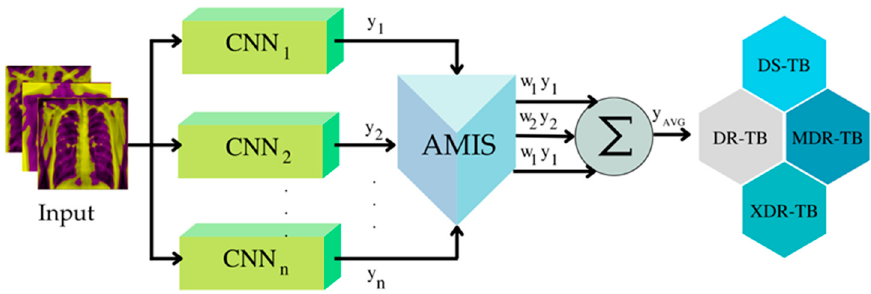
Figure 11. Framework of how to use weight generation to find the optimal weight of ensemble DL.